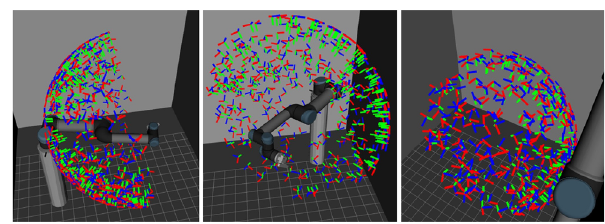
Fig. 6 Candidate views by sphere sampling. Reproduced with permission from Ref. [17], c (cid:2) IEEE